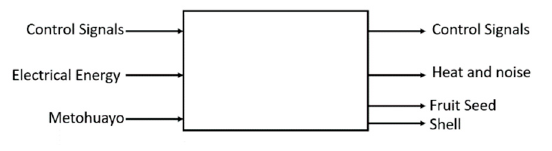
Figure 4. Black box of the machine.